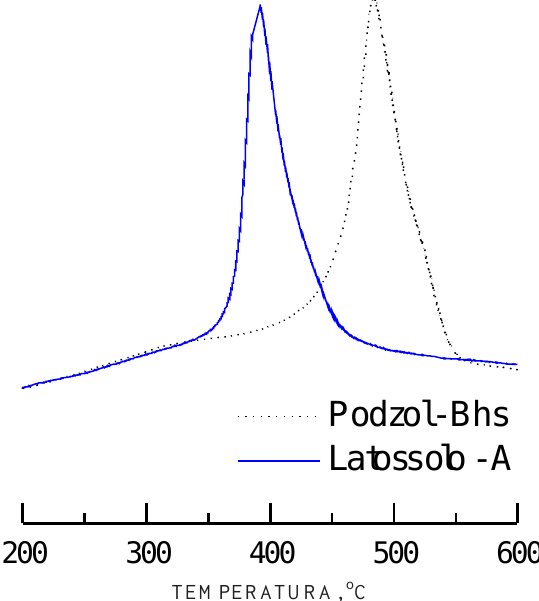
Figura 6. Espectro de análise termodiferencial de ácidos húmicos purificados, extraídos do horizonte A de um Latossolo Vermelho-Amarelo e do horizonte Bhs de um